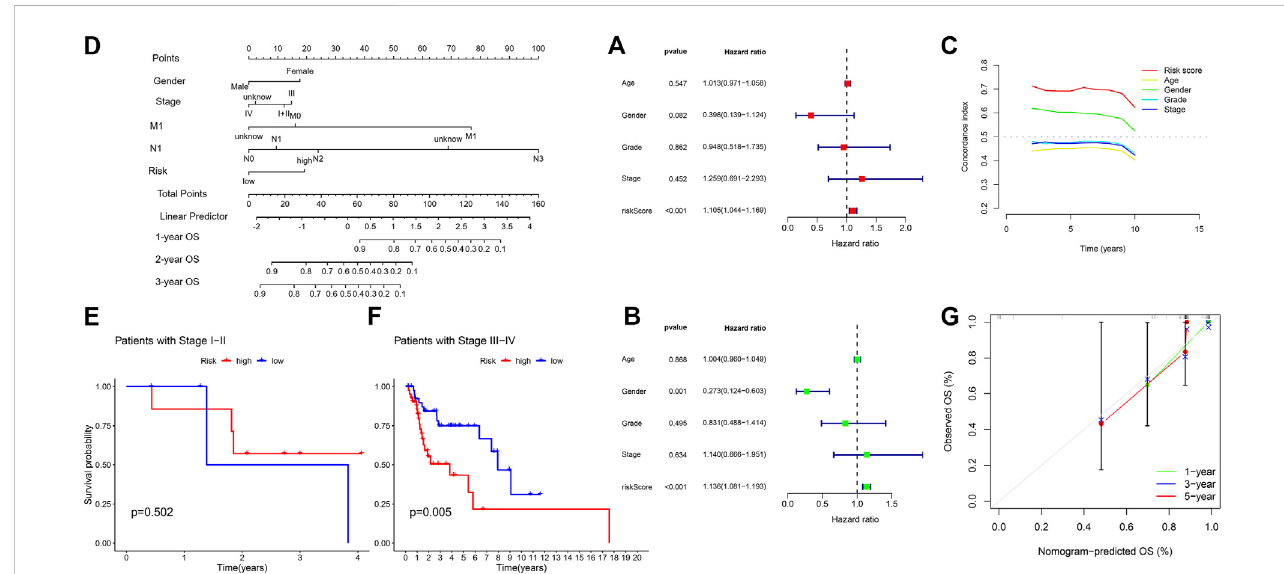
FIGURE 6 (A) Univariate Cox regression analysis between prognostic signatures and overall survival. (B) Multivariate cox regression analysis between prognostic signatures and overall survival. (C) The concordance index of different clinical characteristics and risk scores. (D) Nomogram of prognostic factors to predict the1-,3-and5-yearssurvivalratesofpatientswithHNSC. (E) Kaplan-MeiercurvetoshowoverallsurvivalofpatientswithearlystageI-IItumorindifferentrisk groups. (F) Kaplan-Meiercurvetoshowoverallsurvivalofpatientswithlate-stageIII-IVtumorindifferentriskgroups. (G) Thecalibrationcurvesbetween the prediction by nomogram and actual survival.